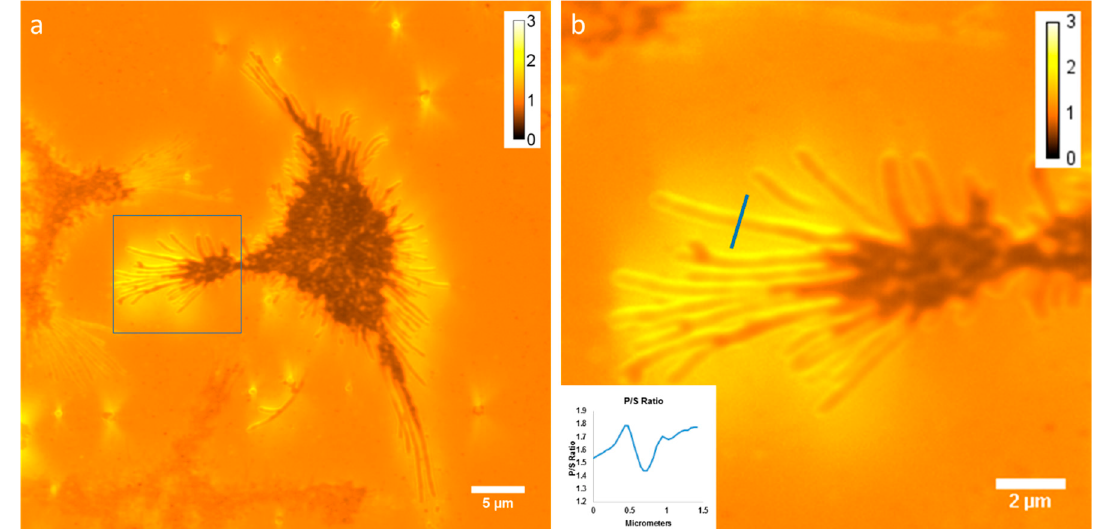
Figure 3. Imaging membrane curvature with DiI-C 16 in RBL-2H3 cells grown on a coverslip acquired with the Zyla 4.2+ sCMOS camera. ( a ) Average of 40 P/S ratio images. ( b ) Zoom of the region indicated in a. The inset shows a plot of the P/S ratio along the indicated line (from top to bottom of the line).